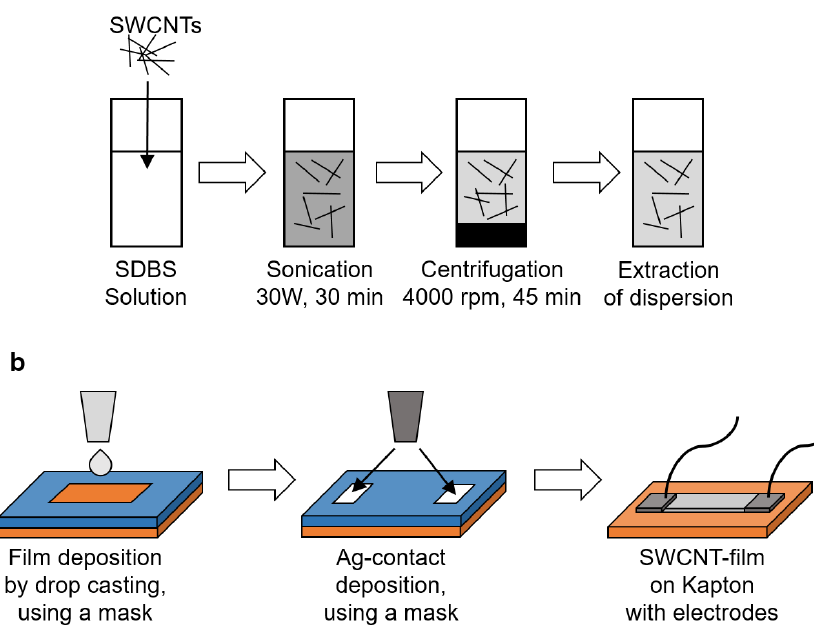
Figure 1. Film fabrication process: ( a ) Dispersion preparation and ( b ) Film